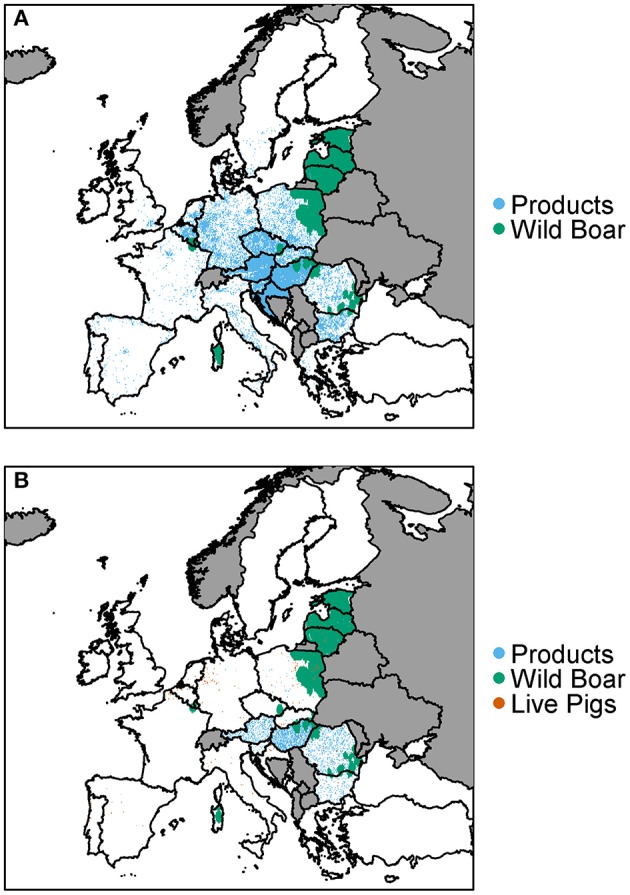
The pathway which has the highest risk of infection of ASFV for (A) wild boar and (B) pigs is plotted at a 100 km2 cell level across Europe. Countries in gray have insufficient data to complete the risk assessment.